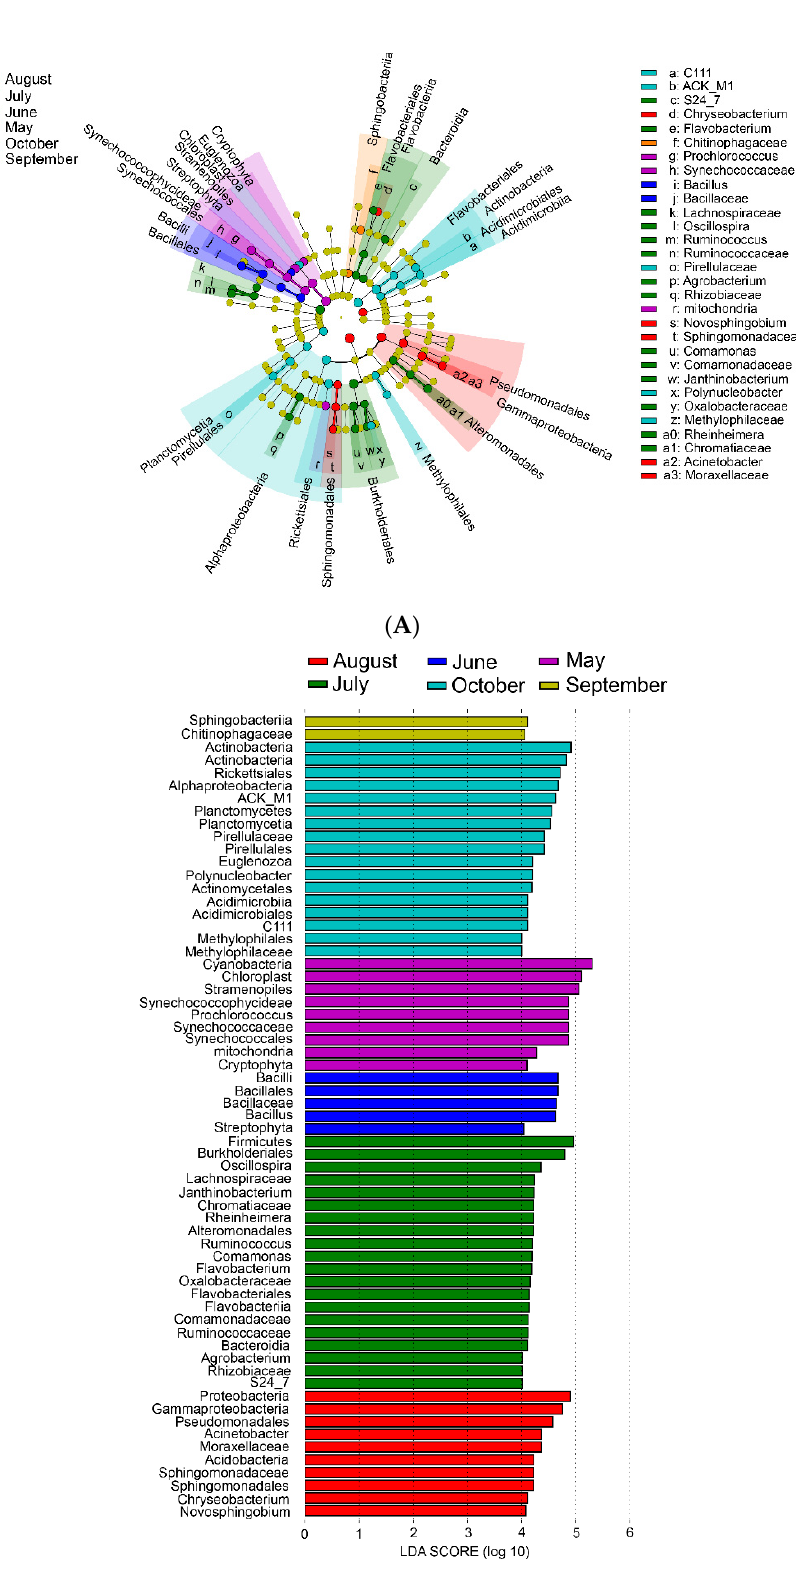
Figure 3. LEfSe analysis of different microbial taxa between different months. ( A ) Cladogram representing the LEfSe results of bacteria at different genus levels. Different colors represent different months. ( B ) Histogramof different microbial taxa found by LEfSe ranking between different months. Only taxa with LDA scores > 4.0 are shown.